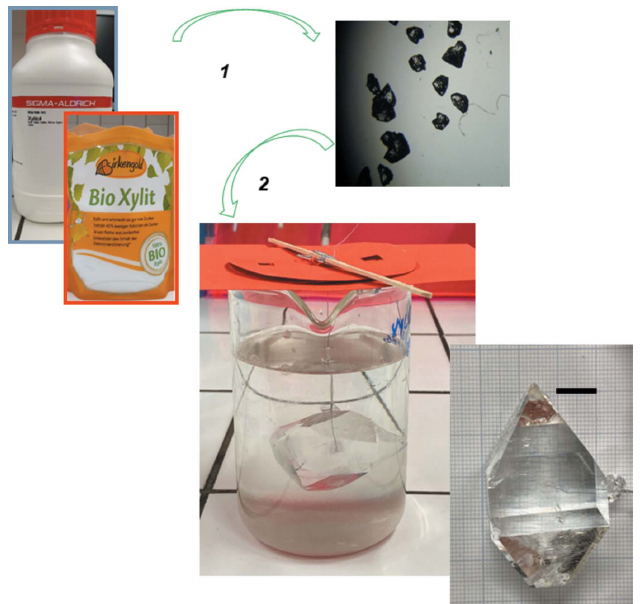
Figure 4 Growing large xylitol crystals. (1) Preparation of seed crystal. A seed crystal, glued to the end of a cotton thread, is placed in an aqueous saturated xylitol solution ( (cid:4) 170 g of xylitol dissolved in 100 mL of water). (2) After several weeks, a large single crystal is obtained. The scale bar represents 10 mm.